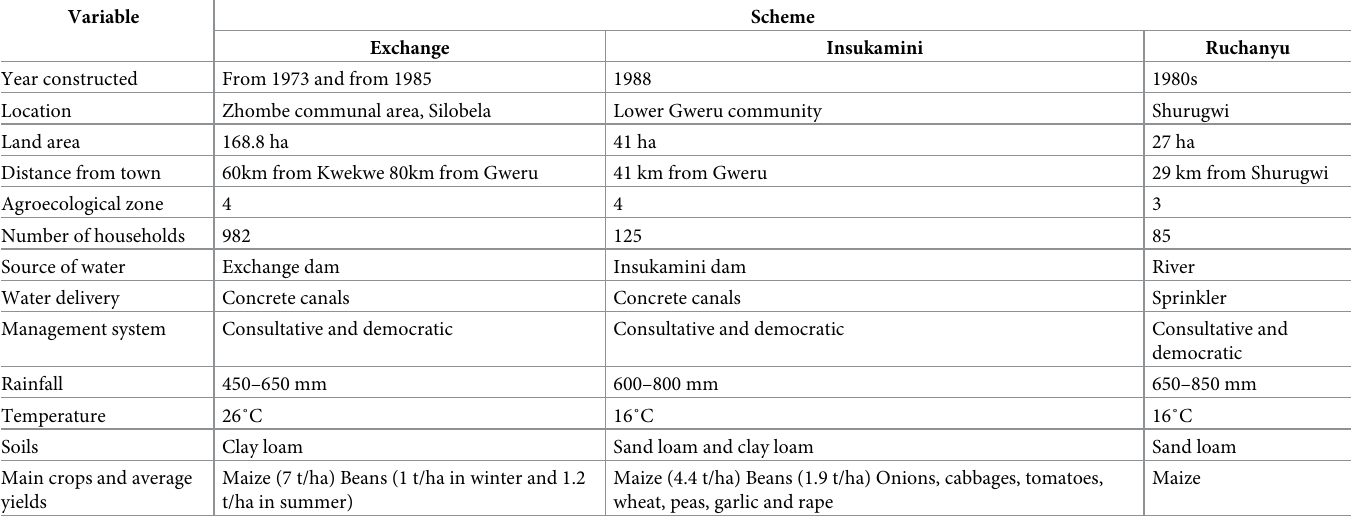
Table 1. Characteristics of Exchange, Insukamini and Ruchanyu irrigation